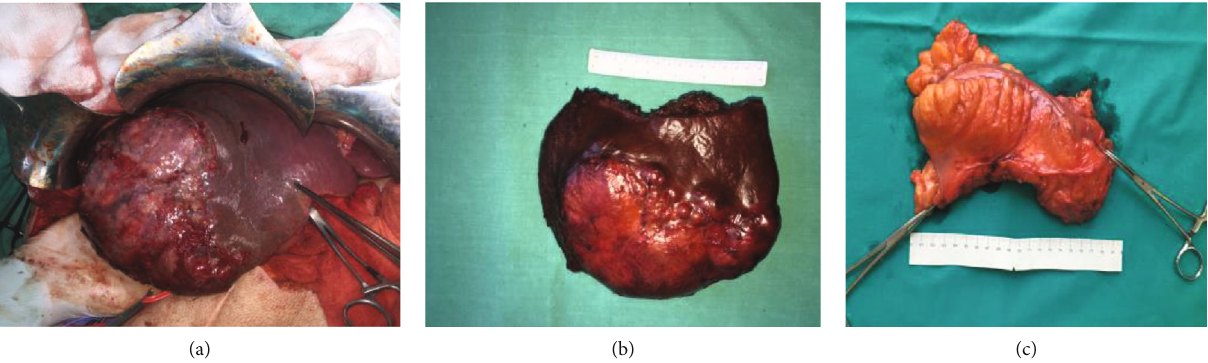
Figure 4: Intraoperative photo of HCC (a). Surgical specimen of the liver (b) and the rectosigmoid colon (c).